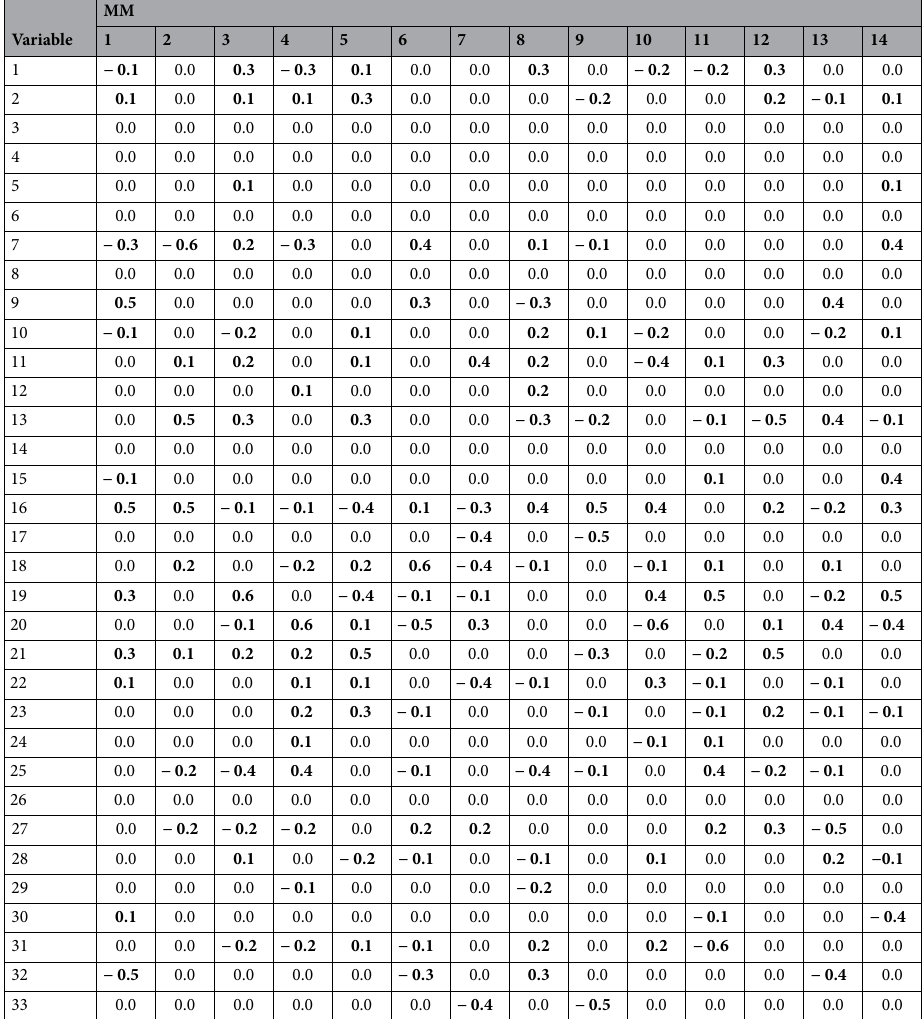
Table 5. Matrix ˜ P r for the Tennessee Eastman process. Significant values are in [bold].